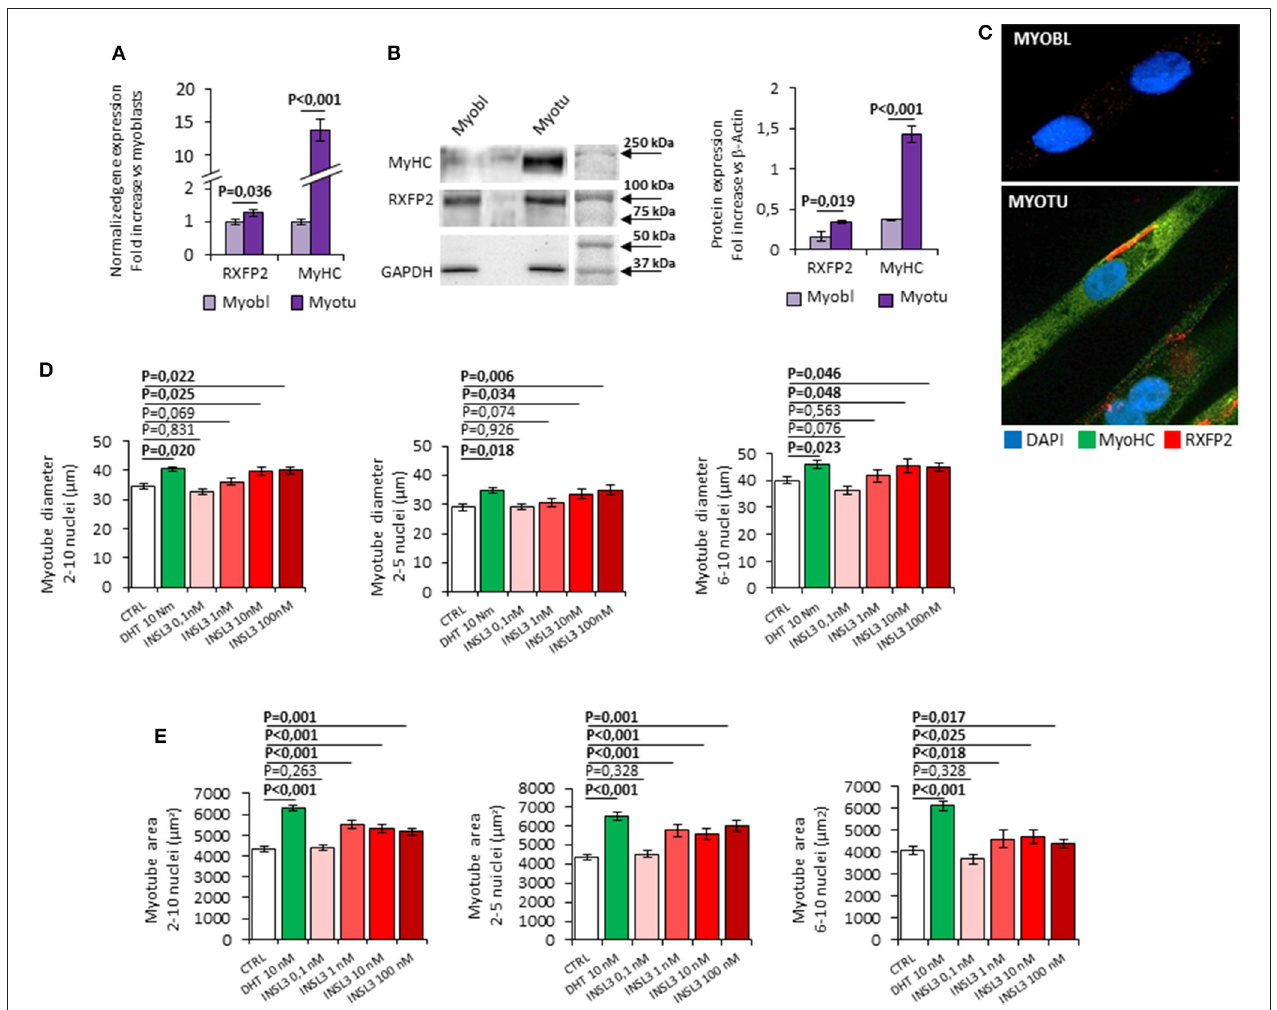
FIGURE 1 | (A–C) Expression of RXFP2 and Myosin-Heavy Chain (MyHC) in cultured myoblasts (Myobl) and myotubes (Myotu) from C2C12 mouse cell line. (A) Gene expression analysis. Gene expression analyzed using qRT-PCR, normalized to housekeeping β -Actin gene expression, is reported as fold increase vs. expression in myoblasts. (B) Representative image of protein expression analysis by western blot and quantification of protein band density. Protein analysis is reported as fold increase vs. GAPDH band density. (C) RXFP2 (red) and MyHC (green) staining on myoblasts and myotubes at immunofluorescence. Cells were counterstained with DAPI (blue). (D,E) Effect of INSL3 stimulation on mature myotubes cell diameter (D) and area (E) . Cells were cultured in differentiation medium containing INSL3 at concentration ranging from 0,1 to 100nM. Dihydrotestosterone (DHT) 10nM was used as reference trophic factor. Cell size was evaluated in all mature myotubes (2-10 nuclei) and further distinguished into low nuclei- (2-5 nuclei) and high nuclei-clustering (6-10 nuclei). Data are reported as mean values ± standard error of the mean of three independent experiments. Significance: P -values between compared conditions are reported. Significant differences ( P < 0.05) are highlighted in bold.